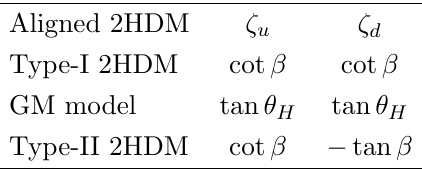
i p 2[ (cid:16) d m b P R (cid:16) u m t P L ] =v , where P R;L = (1 (cid:0) (cid:0)